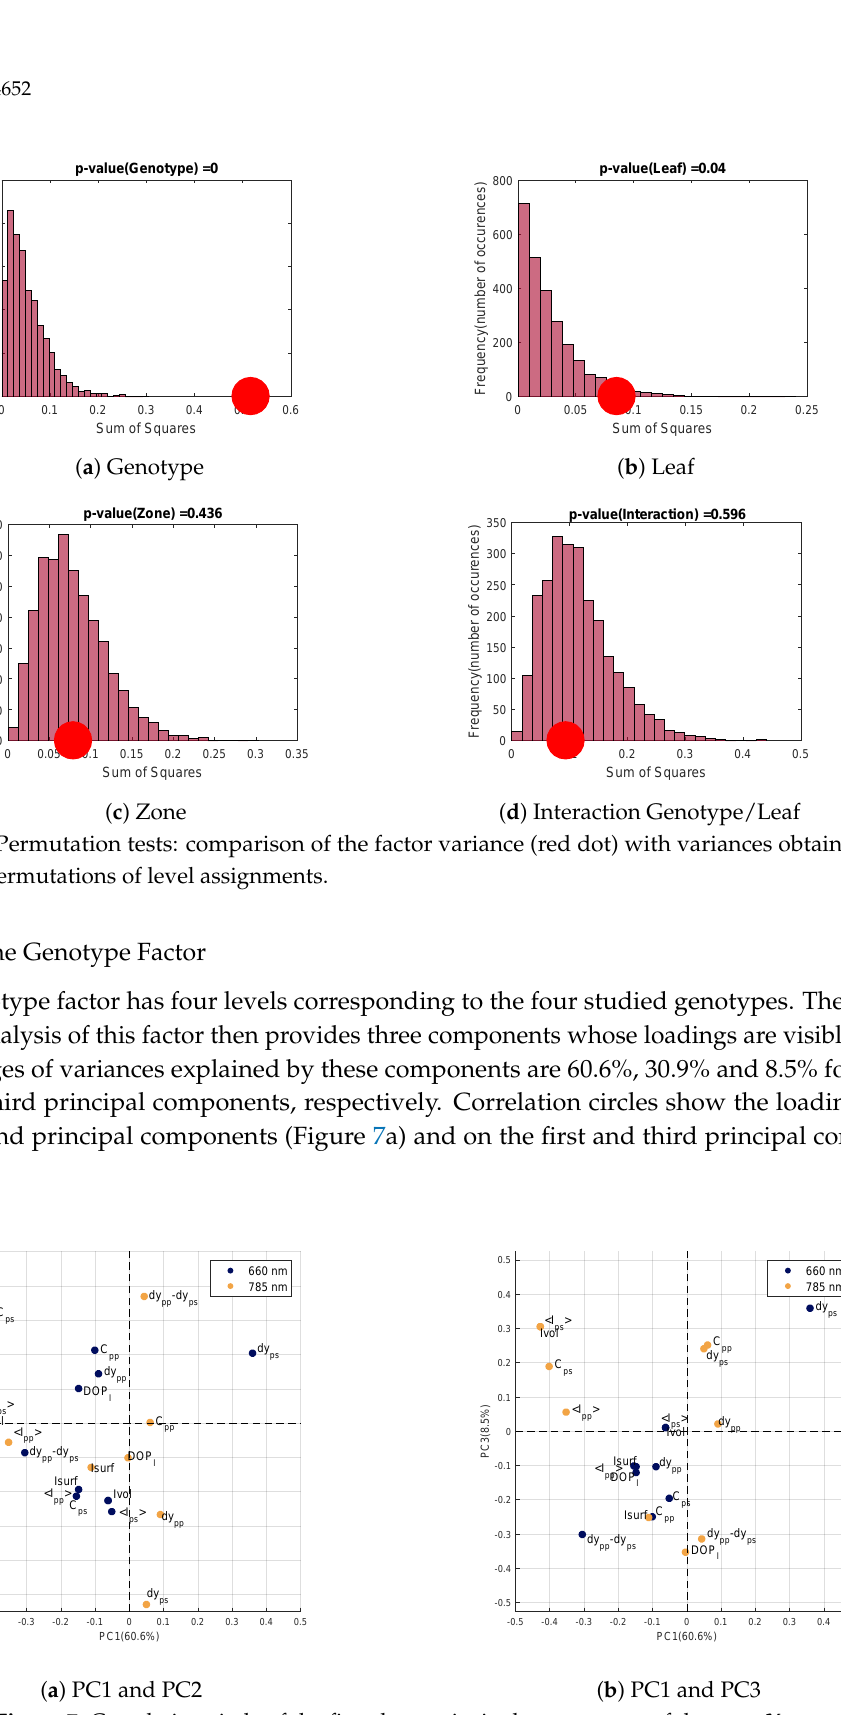
Figure 7. Correlation circle of the first three principal components of the term X G